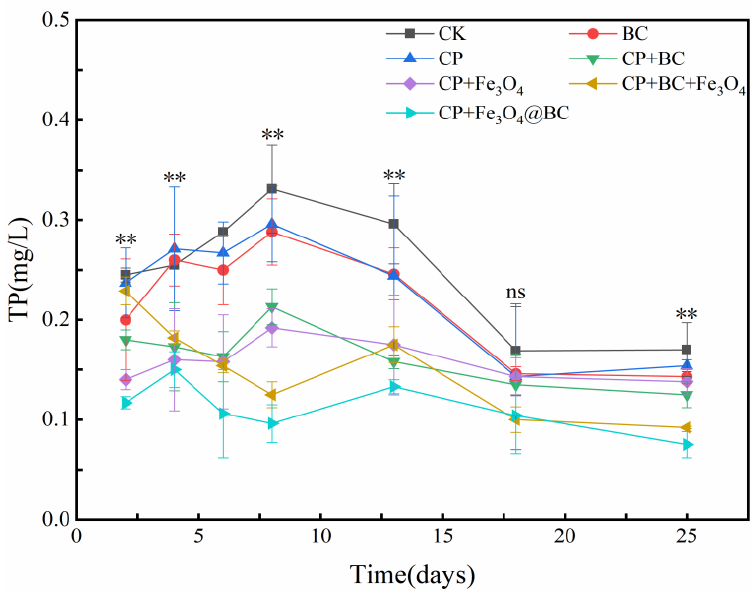
Figure 5. The variation of TP in overlying water during the experimental study; ** indicates a sig- nificant effect at the 0.01 probability level between the control and different treatments; ns indicates no significant effect at the 0.01 probability level between the control and different treatments.